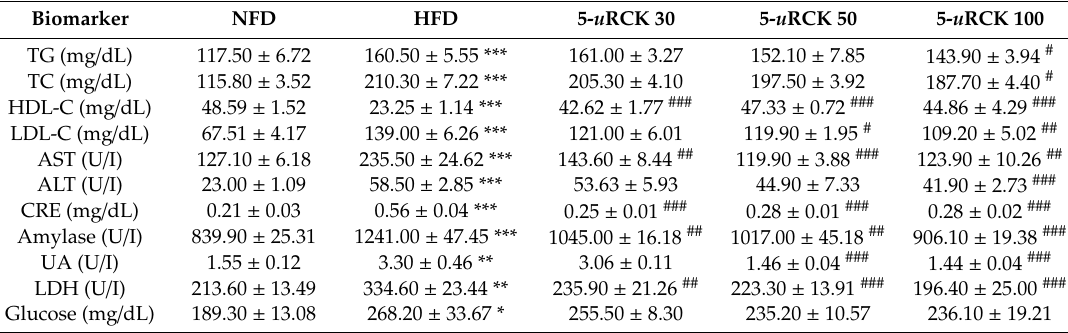
Table 1. E ff ect of 5- u RCK on blood biochemical parameters in HFD-fed